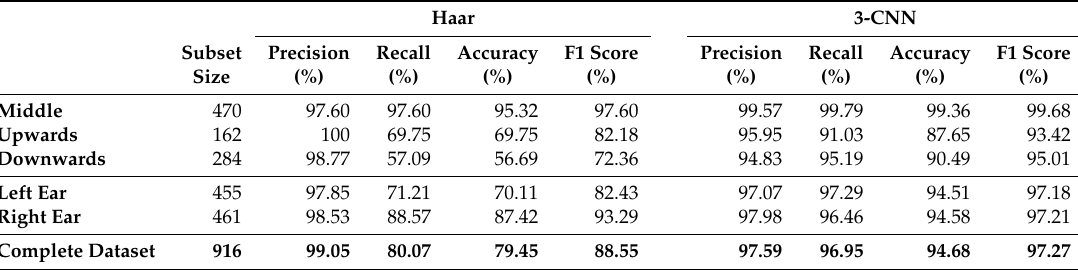
Table 7. Results of testing over the Videos